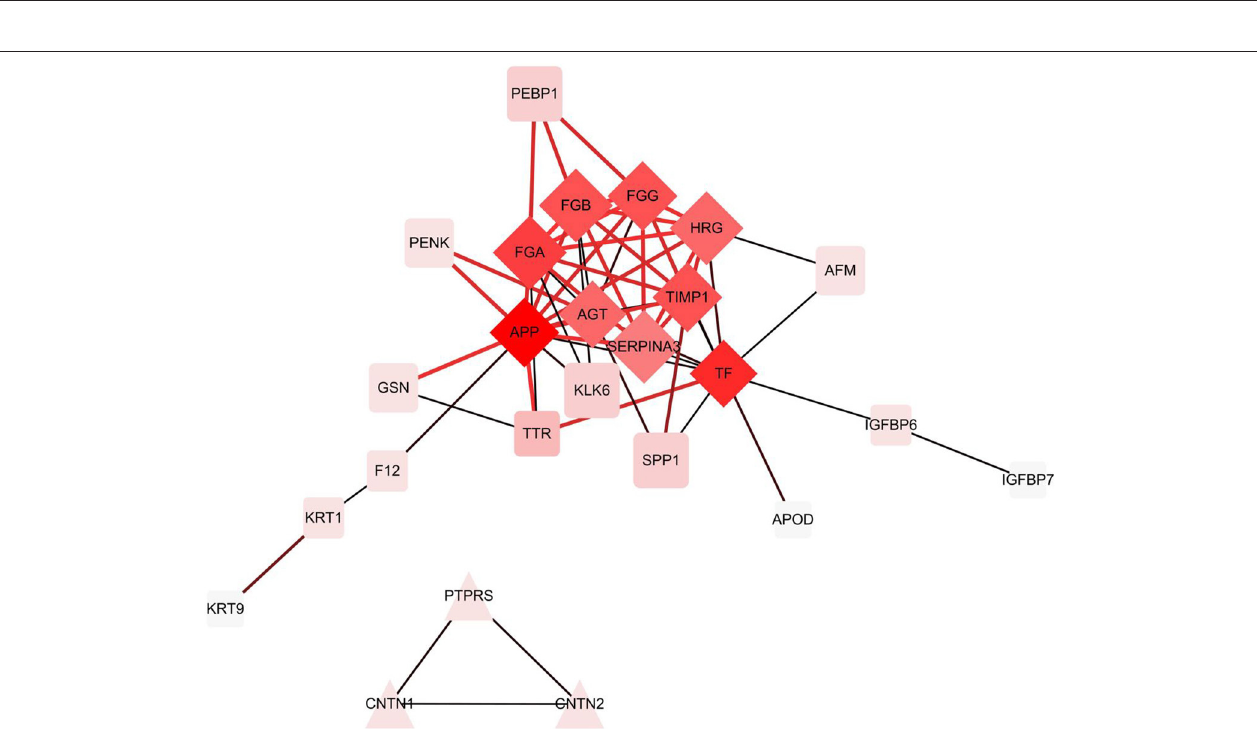
FIGURE 4 | The differential expression proteins interactions analyzed by STRING [Protein -Protein Interaction (PPI) network].